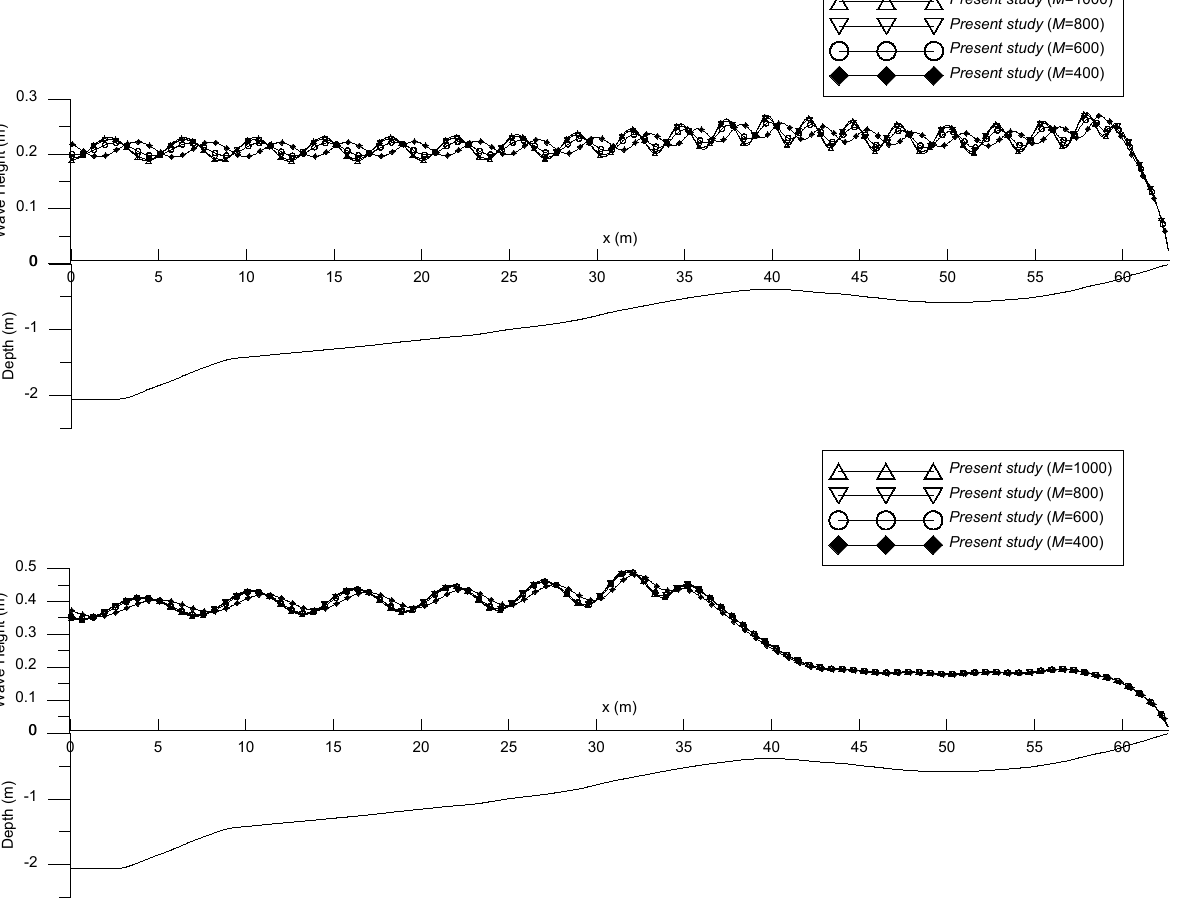
Figure 18. Wave heights for wave breaking and dissipation by a barred beach with various numbers of shelves for the ( up ) spilling and ( down ) plunging breaking cases.